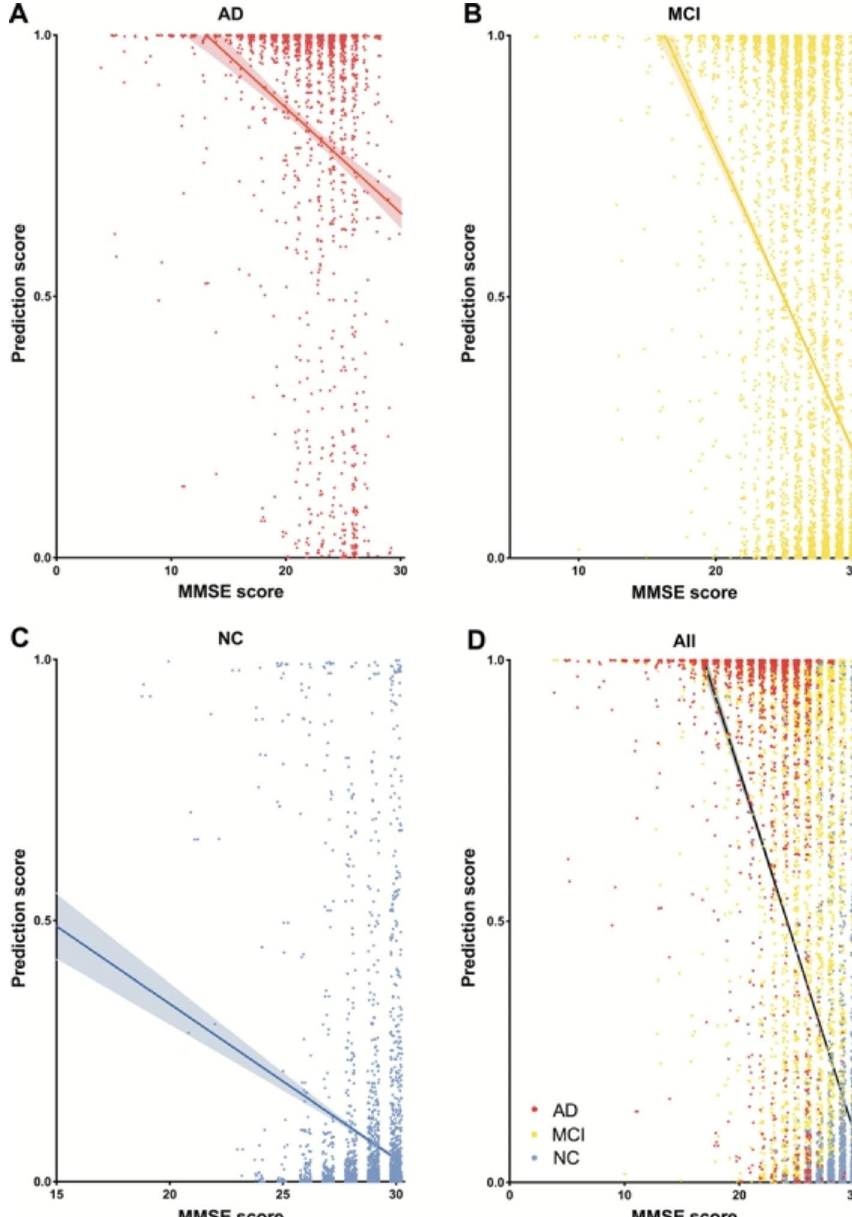
Fig. 5 Correlations between the output of the Alzheimer’s disease (AD) classifier and severity of illness. The pre- dicted scores from the AD classifier showed significant negative correlations with the mini-mental state exami- nation (MMSE) scores of AD, normal control (NC) and mild cognitive impairment (MCI) samples. ( A ) Correlation between the predicted scores from the AD classifier and MMSE scores of AD samples. ( B ) Correlation between the predicted scores from the AD classifier and MMSE scores of MCI samples. ( C ) Correlation between the predicted scores from the AD classifier and MMSE scores of NC samples. ( D ) Correlation between the predicted scores from the AD classifier and the MMSE scores of AD, NC, and MCI samples, MMSE scores differed significantly between pMCI and sMCI (predicted scores: t = 13.88, p < 0.001, Cohen’s d = 1.08; MMSE scores: t = − 9.42, p < 0.01, Cohen’s d = − 0.73, Figure